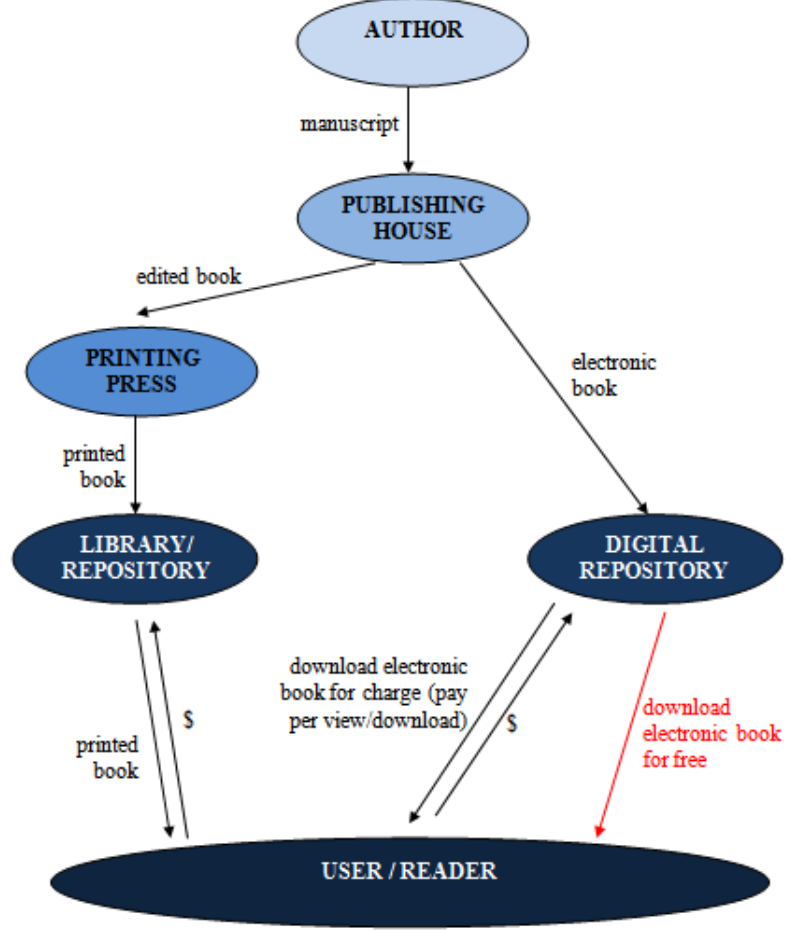
Figure 4. From author to reader.